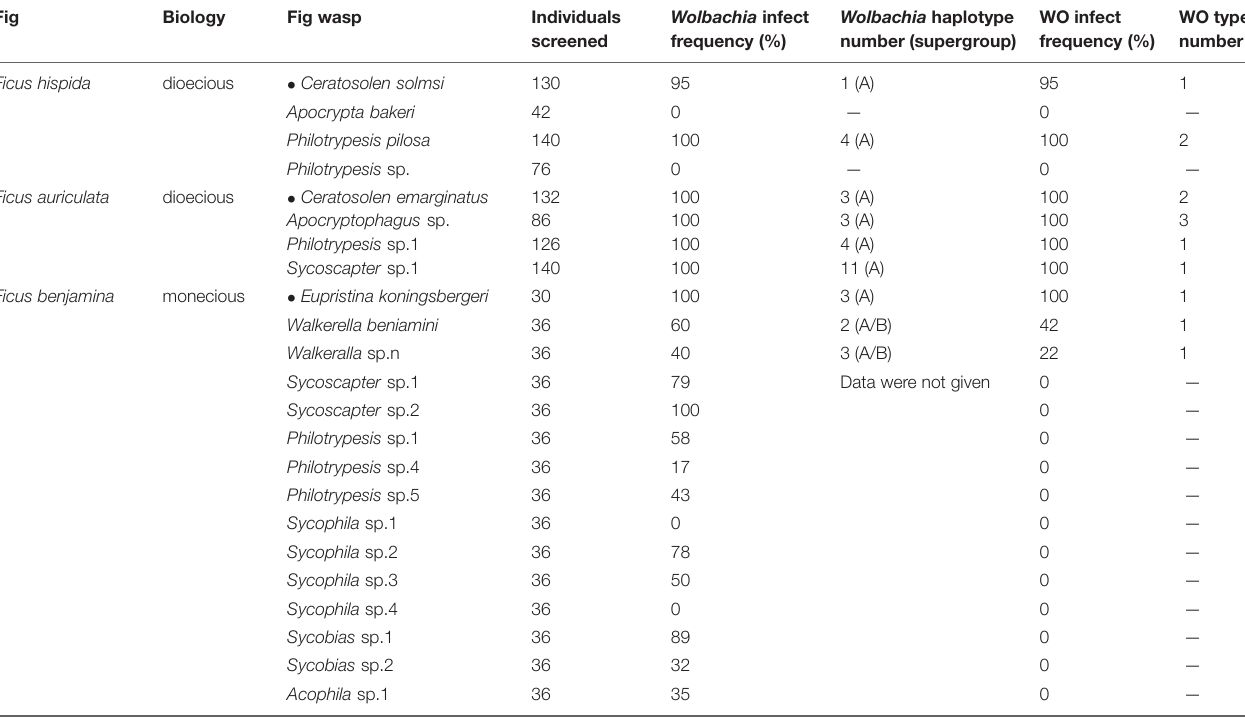
“ • ” indicates the pollinator of each fig; “—”indicates no signal was detected.